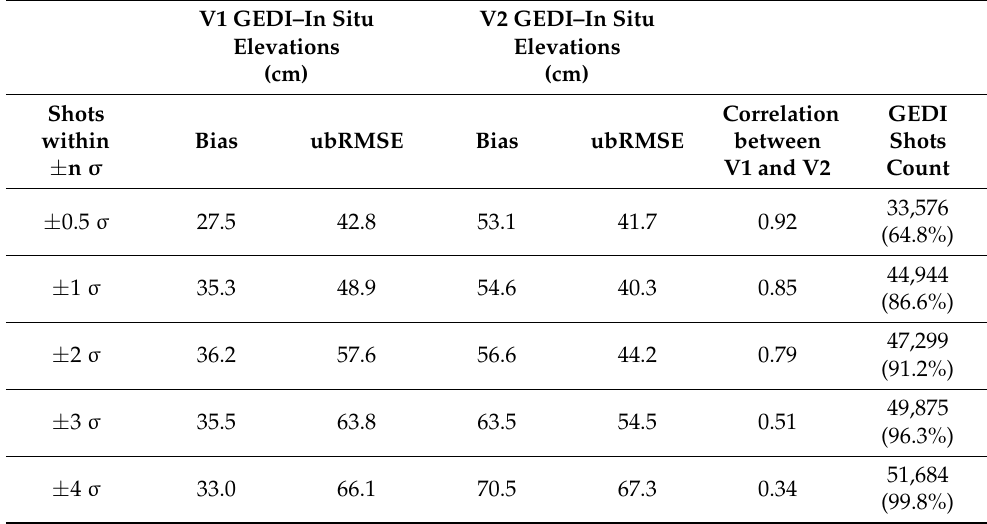
Figure 4. Difference between GEDI V2 and in situ elevations as a function of the difference between GEDI V1 and in situ elevations. Each dot in the figure corresponds to a GEDI shot that was retained after the application of the approach presented in Section 3.2. σ is the standard deviation of the mean difference between V2 and V1 elevations. Table 1. Summary statistics of the difference between V2 GEDI-in situ elevations and V1 GEDI-in situ elevations. σ is the standard deviation of the mean difference between the V2 and V1 elevations.